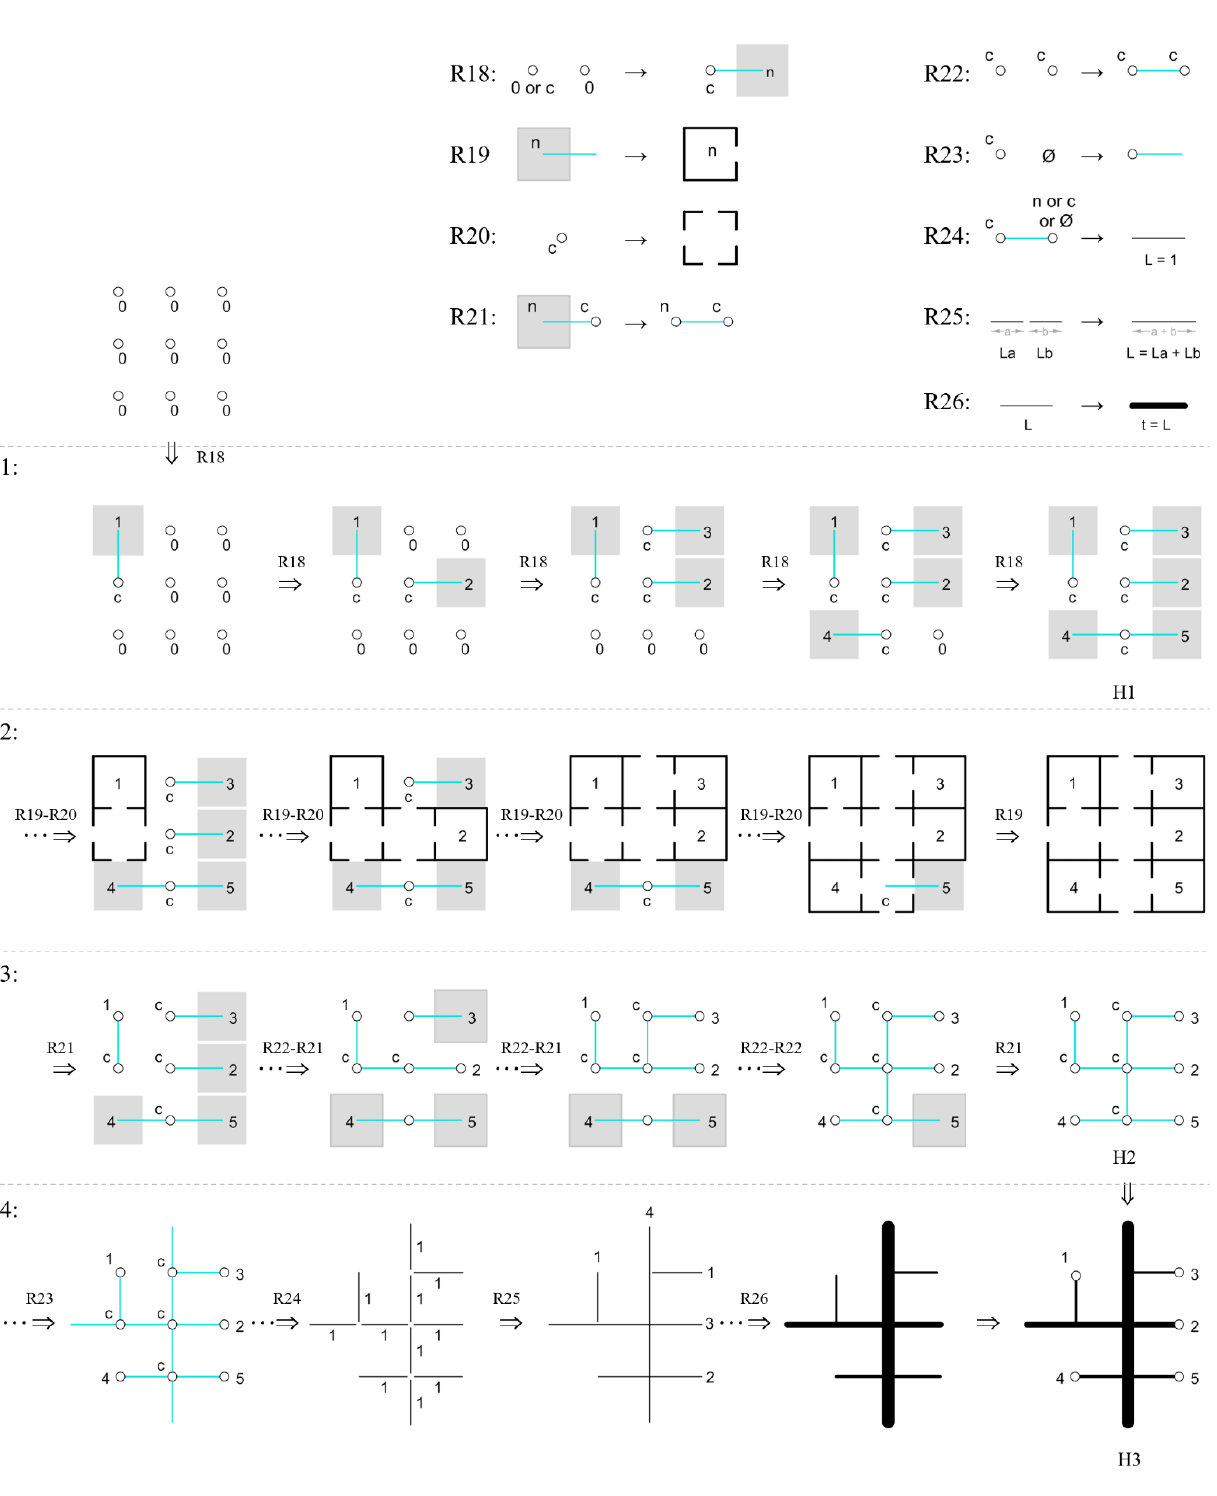
Figure 5. Shape rules (R18–R25) and their iterations to regenerate Hillier’s laws for the construction of spatial orders (H1) in iteration one ( 1 ), laws from society to space (H2) in iteration three ( 3 ), and laws from space to society (H3) in iteration four (combined with graph H2) ( 4 ). Iteration two converts graph H1 into a plan ( 2 ).